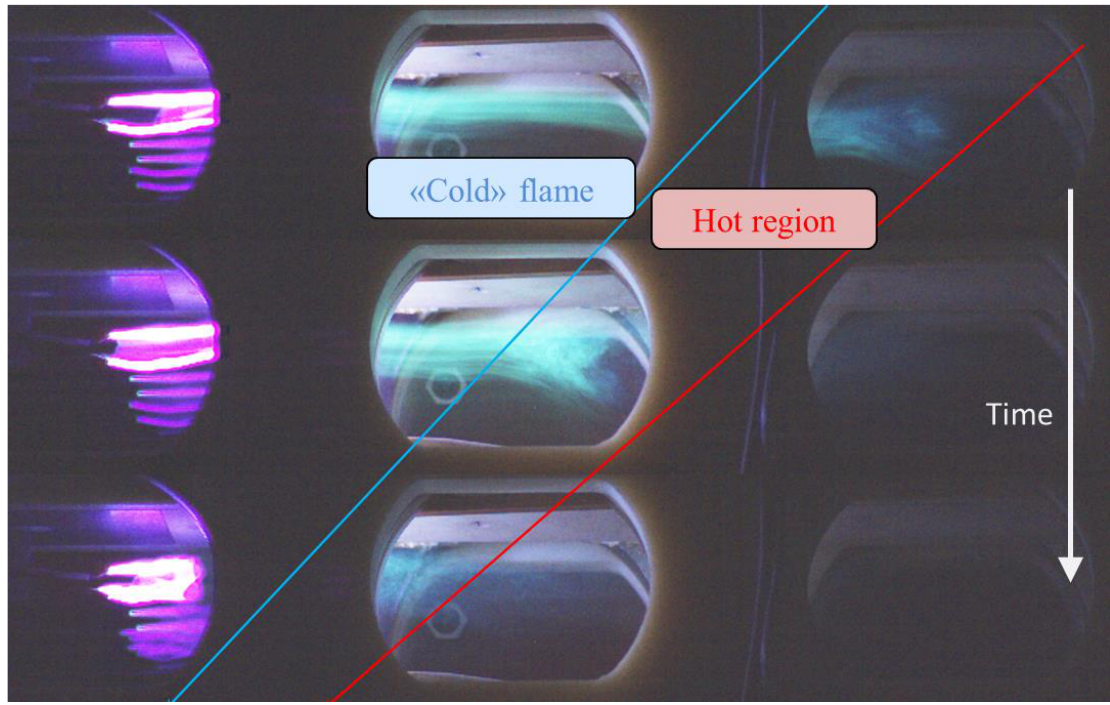
Figure 12. Dynamics of the flame front after ignition for 500 Ω case.